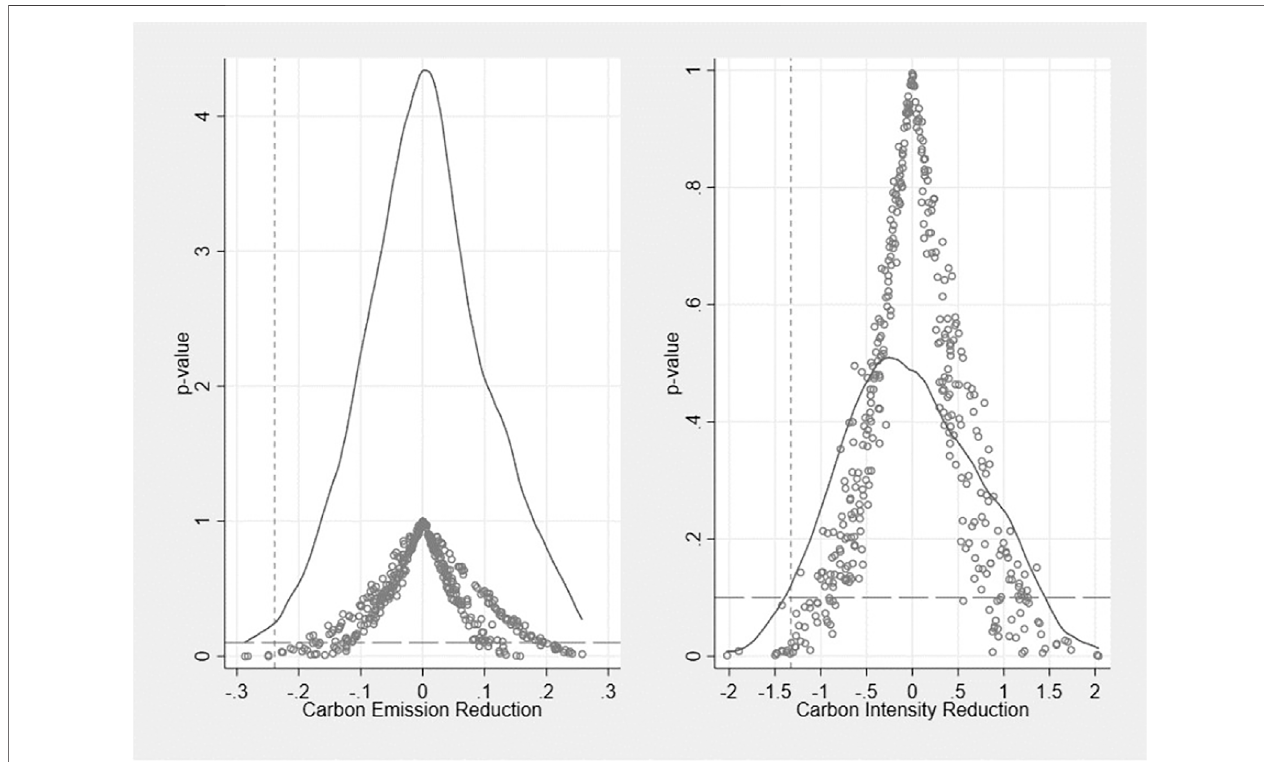
FIGURE 6 | Placebo Test of the Impact of Carbon Trading on Carbon Emissions Excluding Interference. Notes: The X -axis represents the estimated coef fi cients from 400 randomly assigned carbon trading DID items. The curve is the kernel density distribution of the estimated coef fi cients. The points are the p -values of the estimated coef fi cient. The vertical dashed lines are the true estimates, and the horizontal dashed lines represent the 10% signi fi cance level.